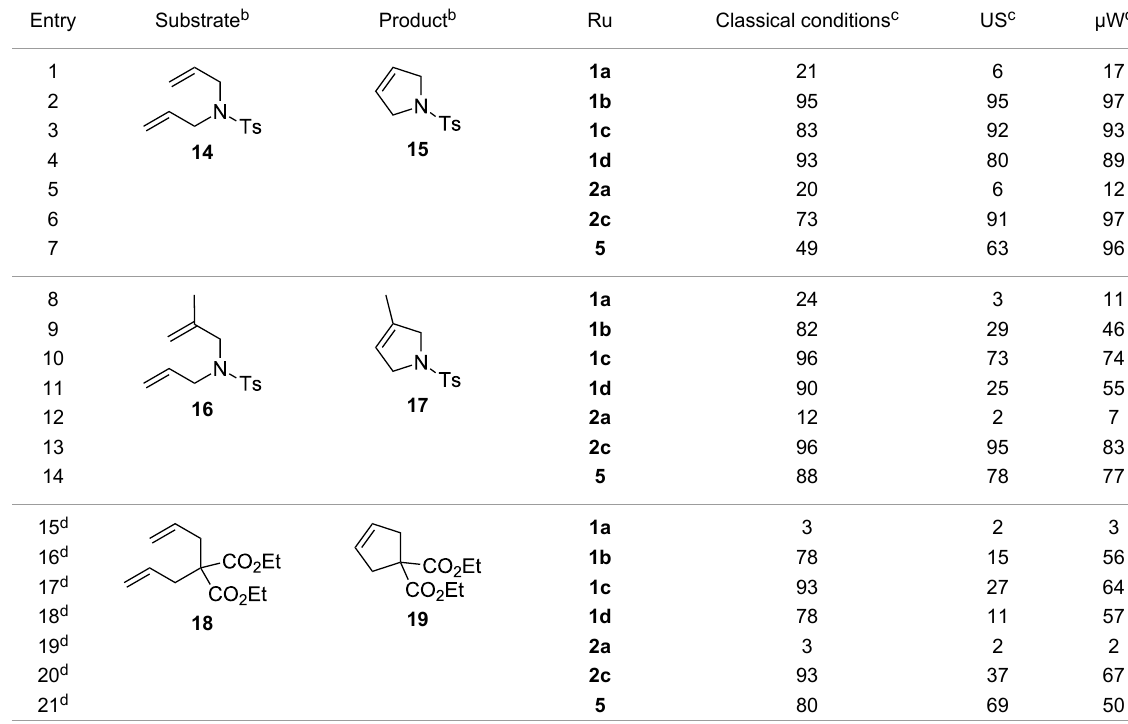
Table 4: Effect of microwave ( μ W) and ultrasound irradiation (US) irradiation on the RCM of lipophilic substrates in water. a